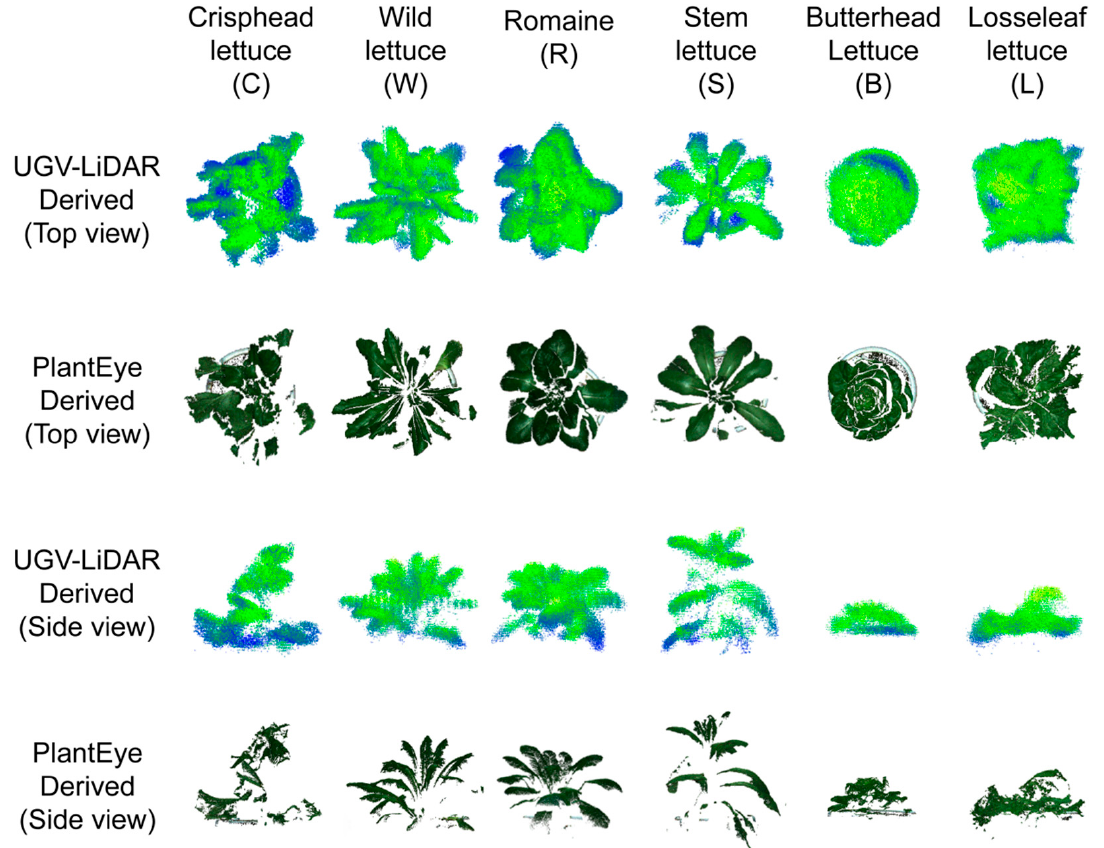
Figure 9. Comparison of the single-point cloud of lettuce plants acquired by UGV-LiDAR platform and PlantEye.